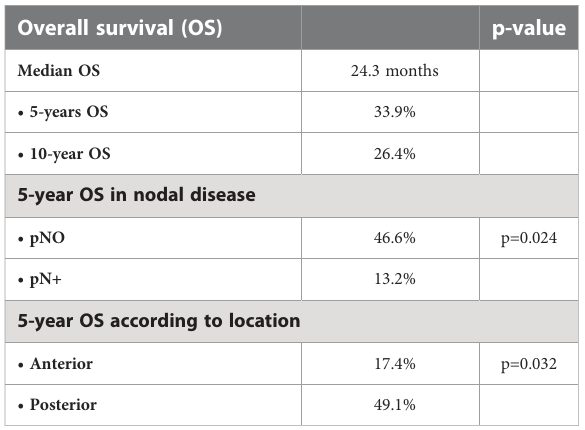
TABLE 2 Survival